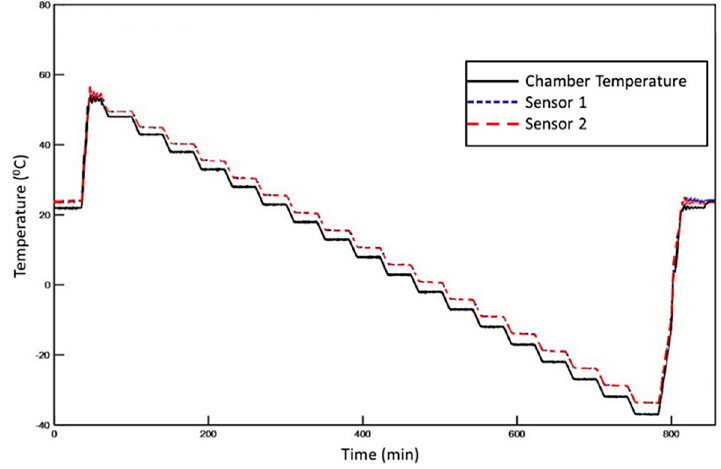
Figure 10. Recorded temperature profile for the chamber and two points on the